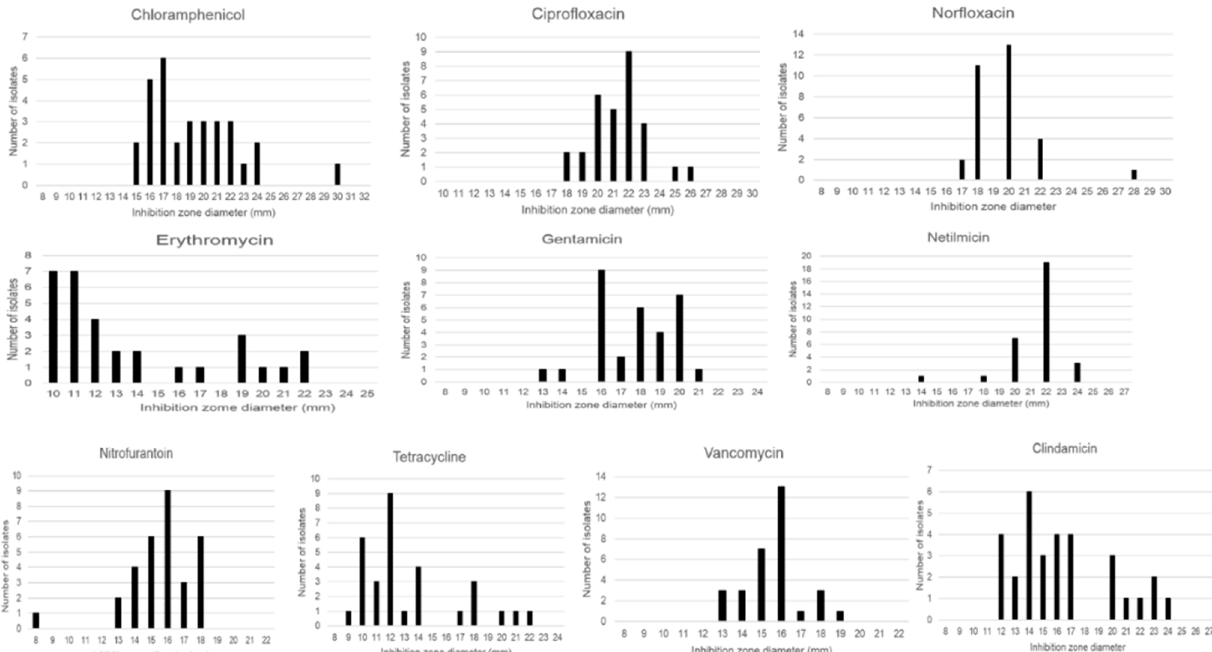
Figure 4. Determination of inhibition zone diameter in the antibiotic disc diffusion tests. Interpretation is based on the EUCAST breakpoints; isolates categorized as susceptible to norfloxacin (S ≥ 17 mm) can be reported as “susceptible increased exposure” to ciprofloxacin (R ˂ 21 mm, S ≥ 50 mm) (see Table 2), vancomycin (R ˂ 10 mm, S ≥ 10 mm), netilmicin (R ˂ 18 mm, S ≥ 18 mm), nitrofurantoin (R ˂ 13 mm, S ≥ 13 mm), gentamicin (R ˂ 18 mm, S ≥ 18 mm), chloramphenicol (R ˂ 18 mm, S ≥ 18 mm), clindamycin (R ˂ 19 mm, S ≥ 22 mm), erythromycin (R ˂ 18 mm, S ≥ 21 mm), and tetracycline (R ˂ 19 mm, S ≥ 22 mm).